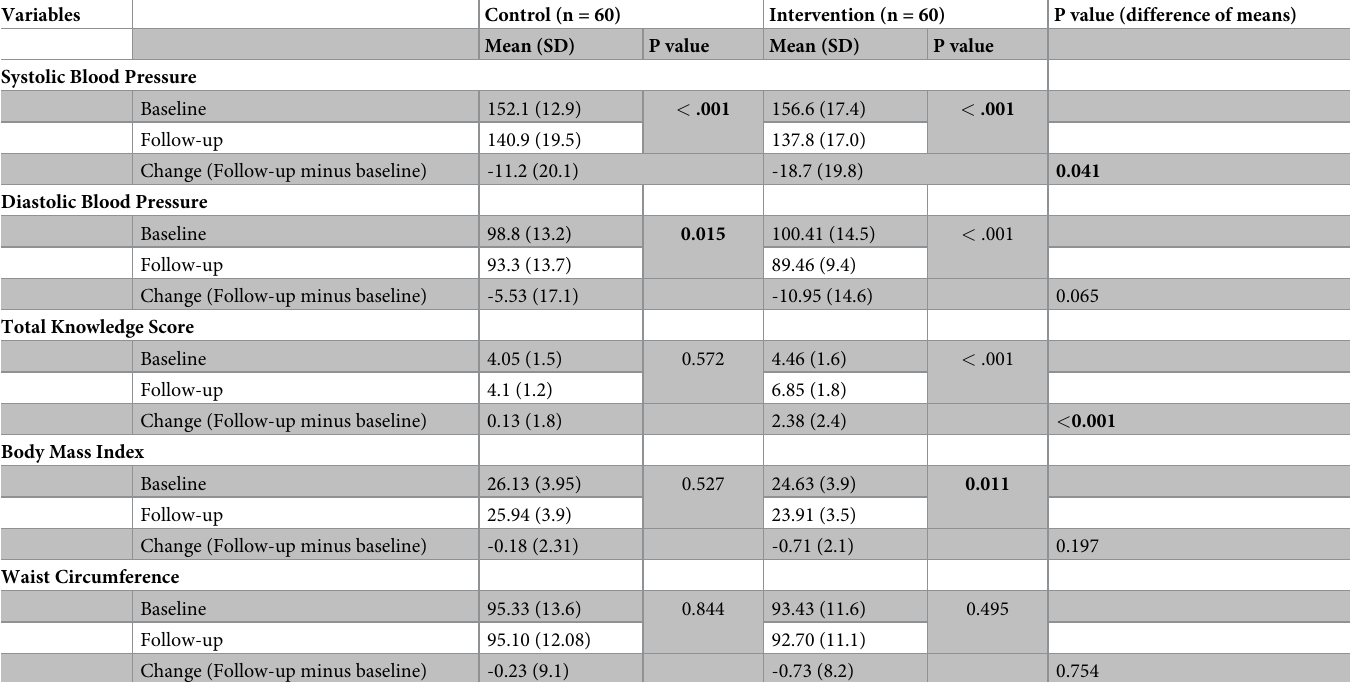
Table 4. Mean blood pressure, body mass index, waist circumference, and knowledge score related to hypertension.